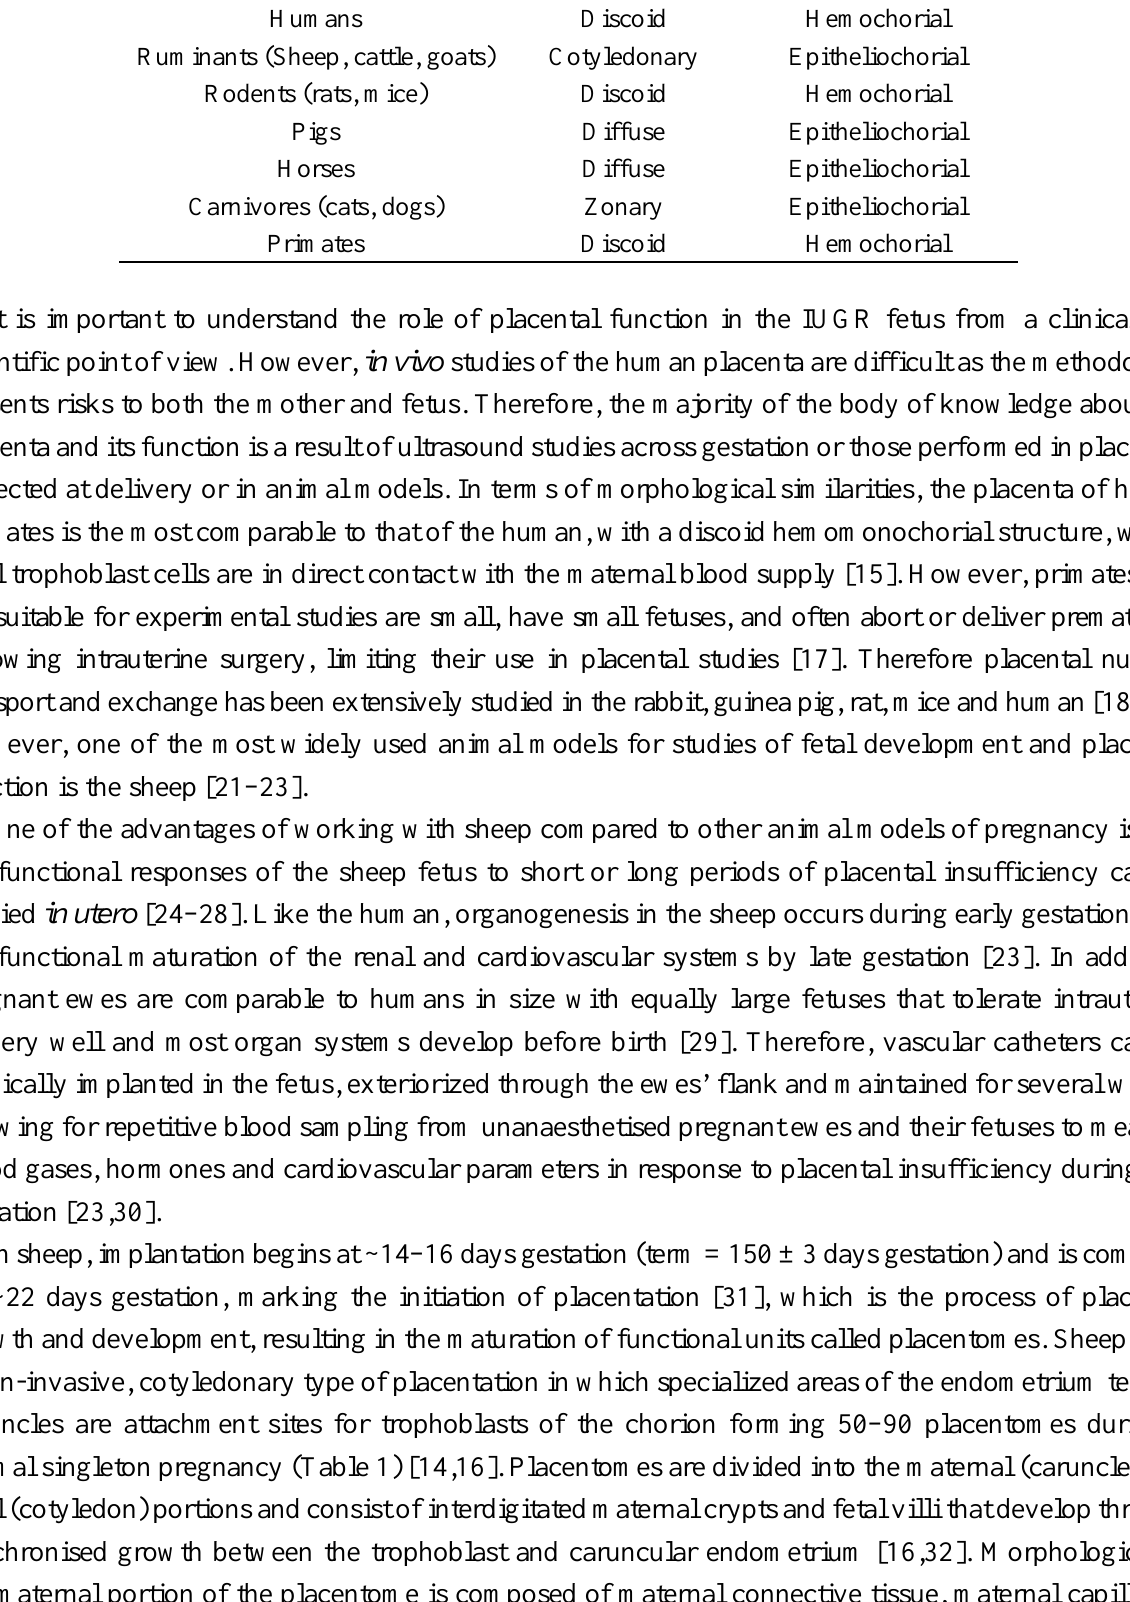
Table 1. An across species comparison of placental shape and structure [14–16]. Species Placental